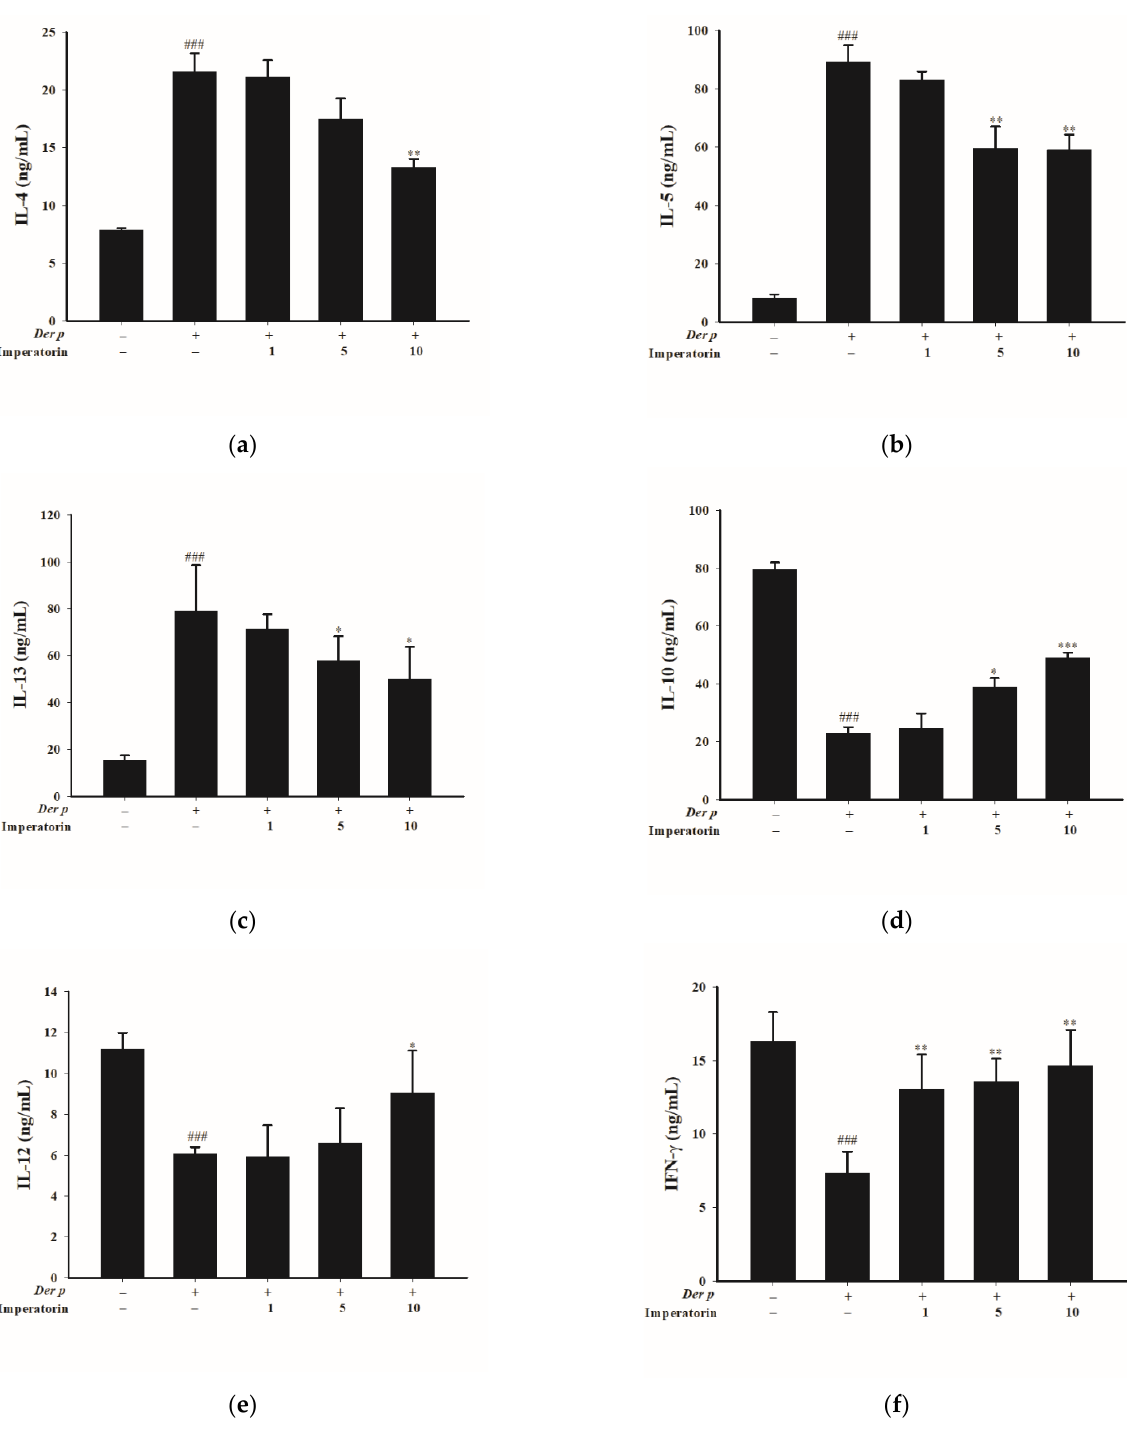
Figure 6. Effects of imperatorin on chemokine levels in the collected BALF of mice with Der p –induced allergic asthma. ( a ) IL-4, ( b ) IL-5, ( c ) IL-13, ( d ) IL-10, ( e ) IL-12, ( f ) IFN- γ . ### p < 0.001 compared with the control group, * p < 0.05, ** p < 0.01 and *** p < 0.001 compared with the Der p -induced group, n = 8 (one-way ANOVA followed by Scheffe’s multiple range test). All data are presented as the mean ±